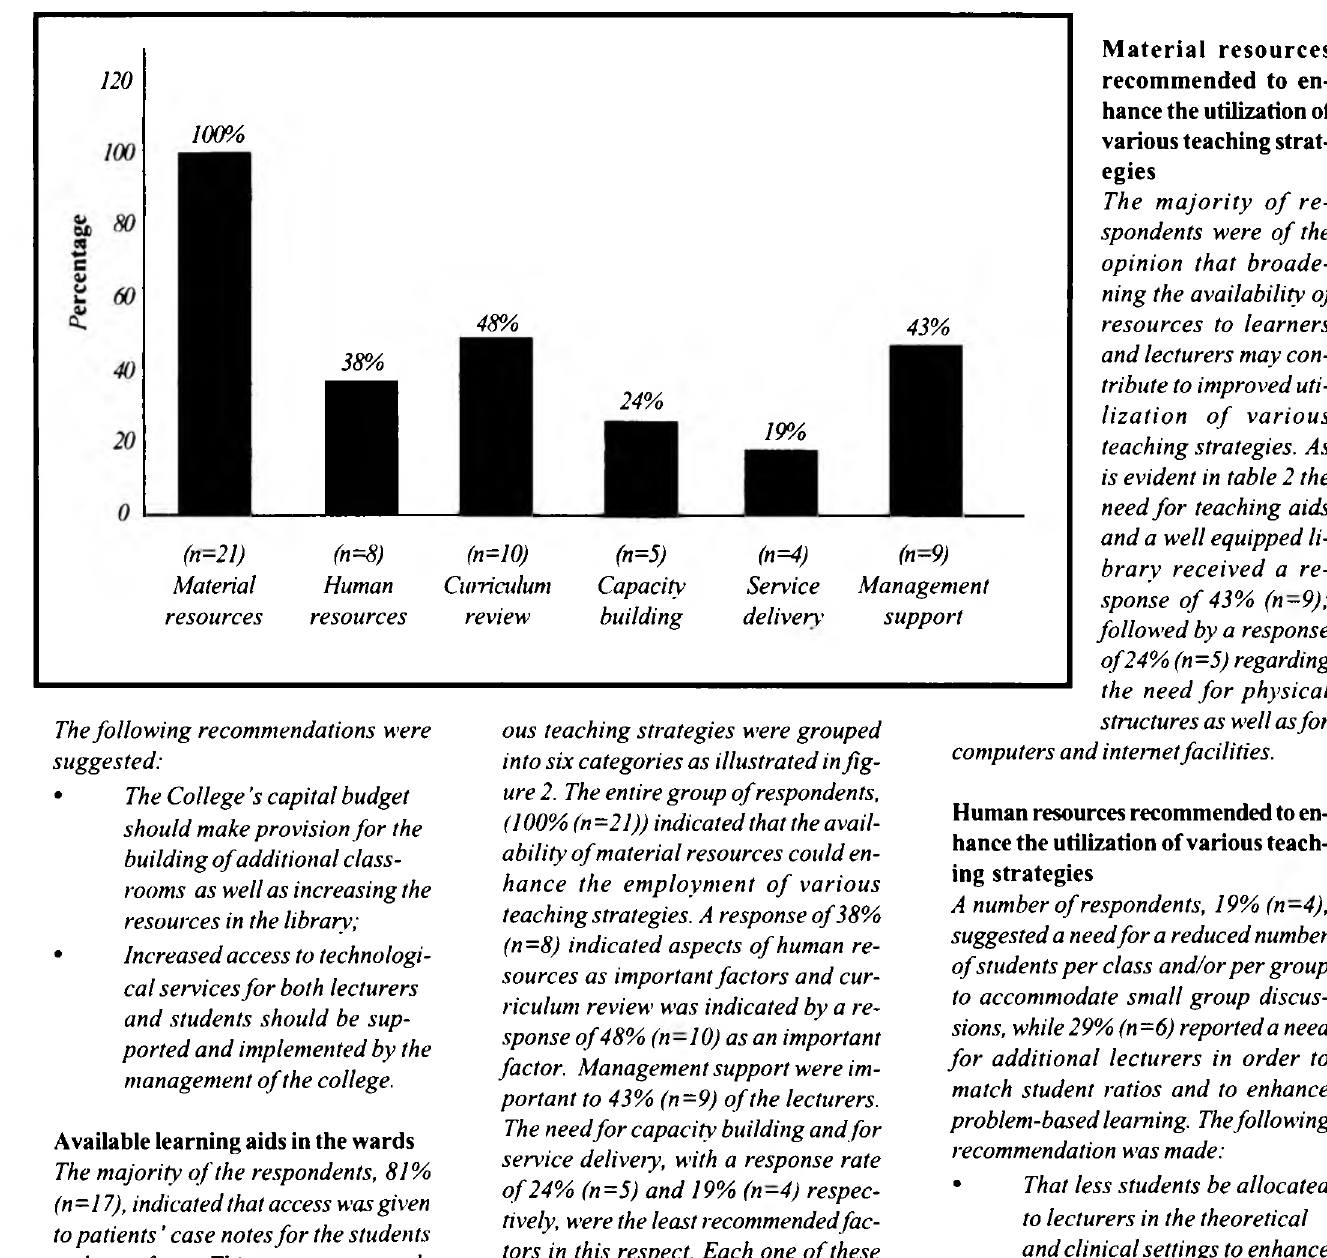
Table 2. Material resources recommended to enhance the utilization